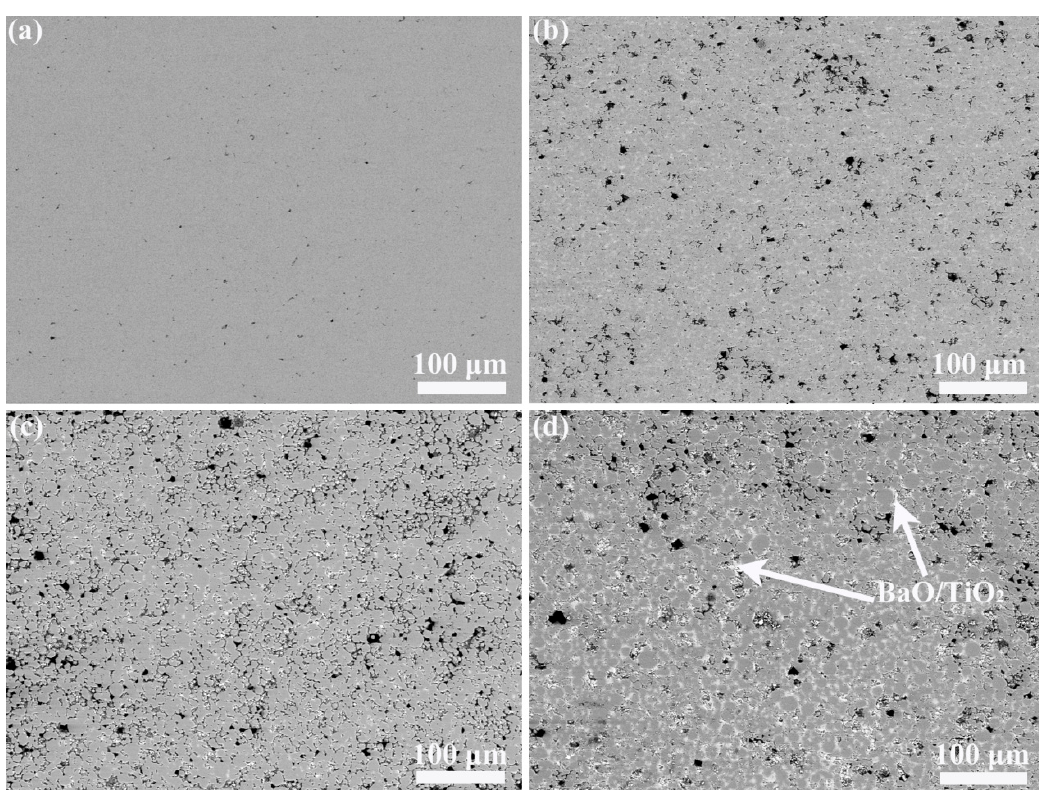
Figure 3. Sintering morphologies of the composites: ( a ) NA; ( b ) NA1; ( c ) NA2; ( d )